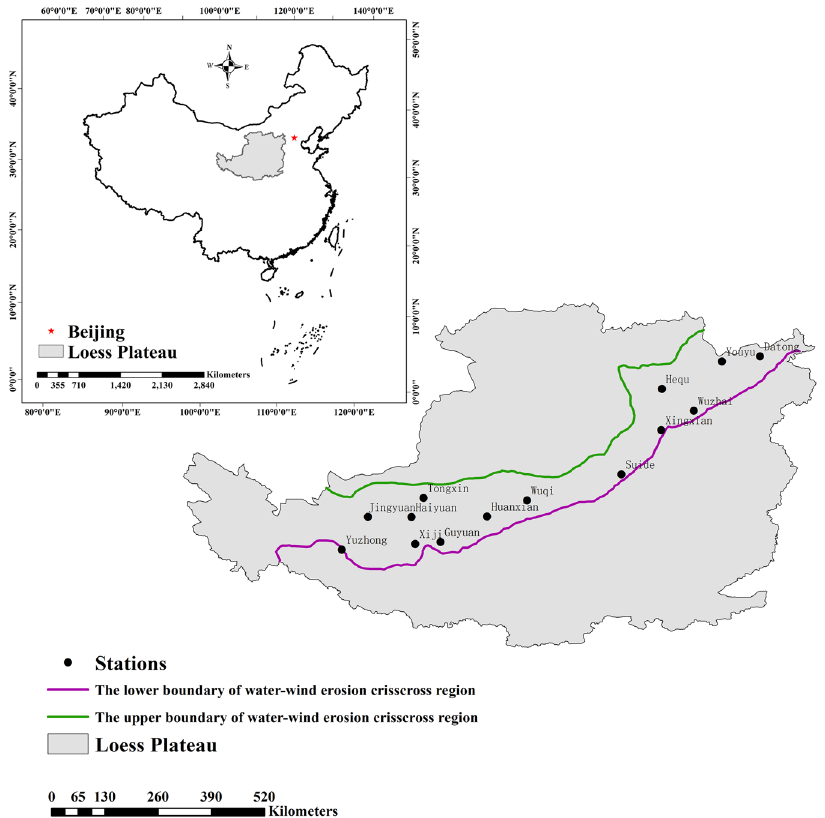
Figure 11. Study area and spatial distribution of the 14 synoptic stations. (The two maps were created using ArcGis 10.2 and then combined together using Adobe Photoshop CS6. ArcGIS 10.2: http://www.esri.com/apps/ products/download/index.cfm?fuseaction = download.all#ArcGIS_Desktop; Adobe Photoshop CS6: http:// www.adobe.com/cn/products/cs6/photoshop.html).